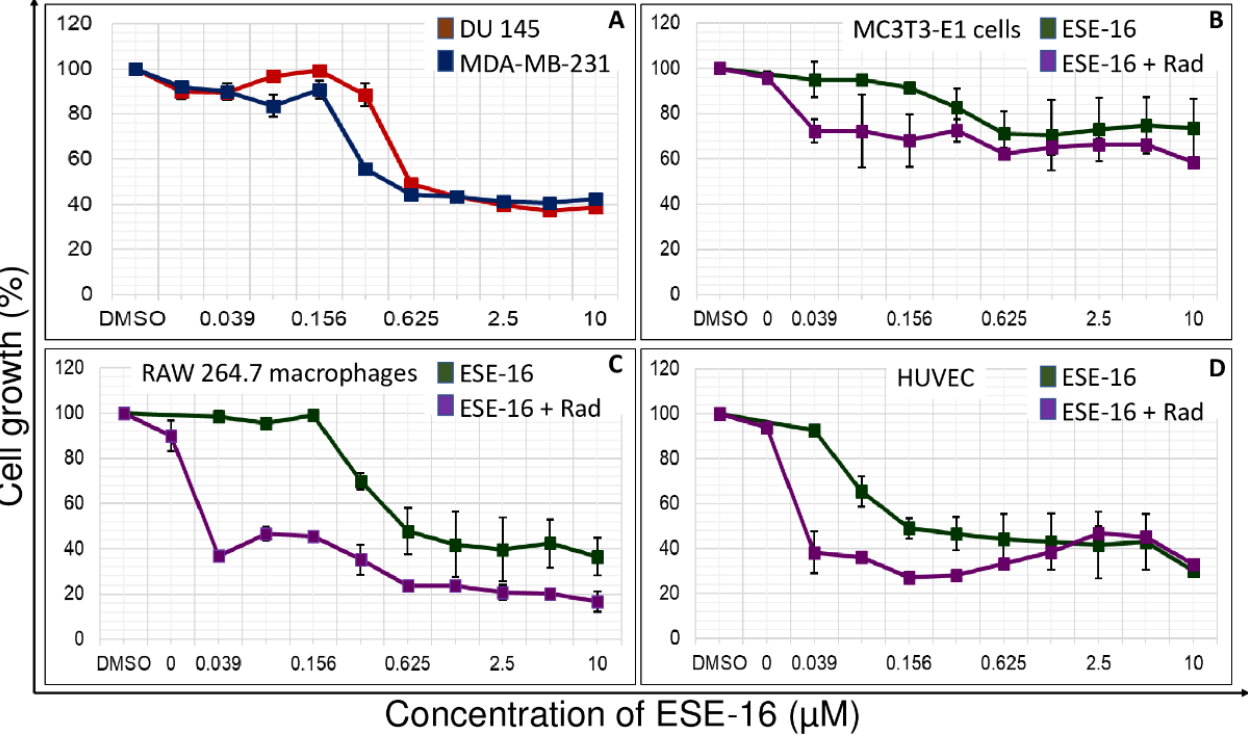
Figure 2. Dose–response curves. ( A ) DU 145 and MDA-MB-231 cells exposed to ESE-16 for 48 h. ( B ) MC3T3-E1 cells, ( C ) RAW 264.7 macrophages, and ( D ) HUVECs exposed to ESE-16 alone as well as ESE-16 in combination with 4 Gy radiation. The 0 µ M data point (of the purple line in ( B – D )) represents the effects of 4 Gy radiation alone. Cytotoxic effects were evident in DU 145-, MDA-MB-231-, RAW 264.7 cells, and HUVECs exposed to ESE-16. Sensitivity to 4 Gy radiation increased in the RAW 264.7 and HUVEC cells when they were pre-exposed to low-dose ESE-16. MC3T3-E1 cells were spared. Data points depict the means of a minimum of three biological repeats each with an n of at least 3. Standard deviation (SD) indicated by T-bars. Table 1. GI 50 values ± SD in DU 145-, MDA-MB-231-, MC3T3-E1-, RAW 264.7 cells, and HUVECs exposed to ESE-16 for 48 h as well as in combination with 4 Gy radiation.